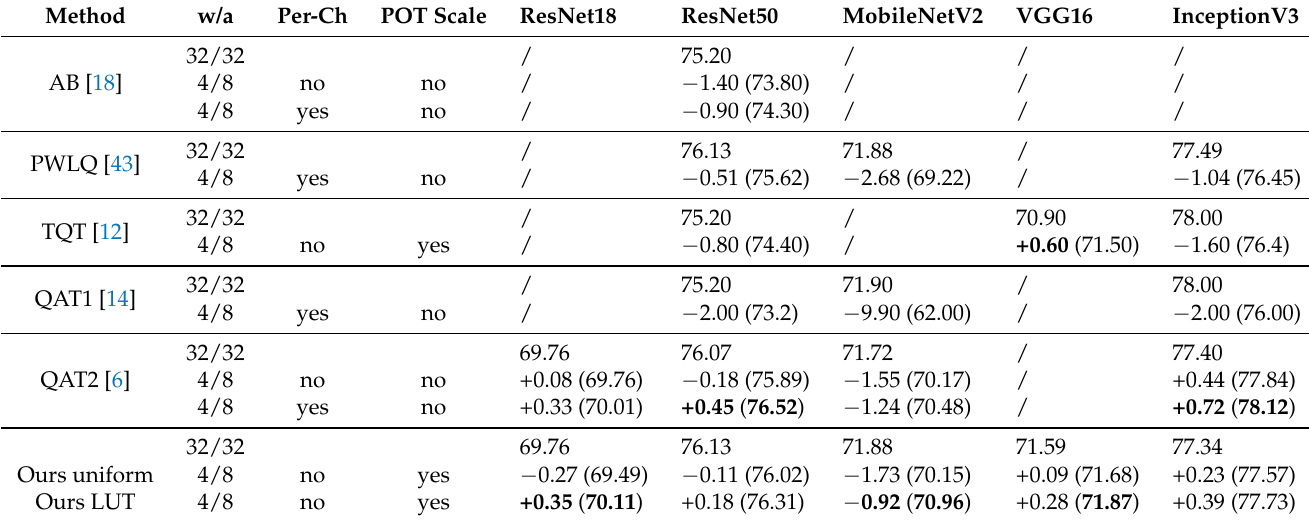
Table 2. Top-1 ImageNet accuracies of different works. The first value represents the relative accuracy or difference between the quantized model and the full-precision model, while the second number in parenthesis represents the absolute accuracy. Columns Per-Ch and POT scale indicate whether per-channel quantization or POT scales were used, respectively. Method